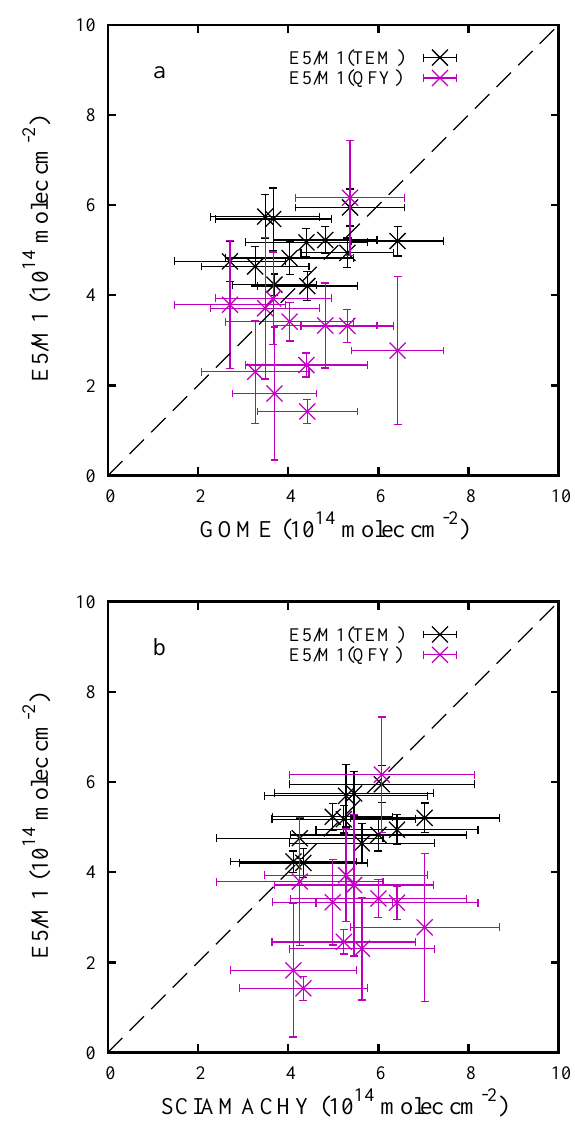
Fig. 8. NO 2 tropospheric column over the shipping lane from India to Indonesia (S). Monthly satellite values, averaged over all available years from (a) GOME and (b) SCIAMACHY are correlated to the model results E5/M1(TEM) and E5/M1(QFY). The error bar for the model simulations shows the interannual standard devi- ation.